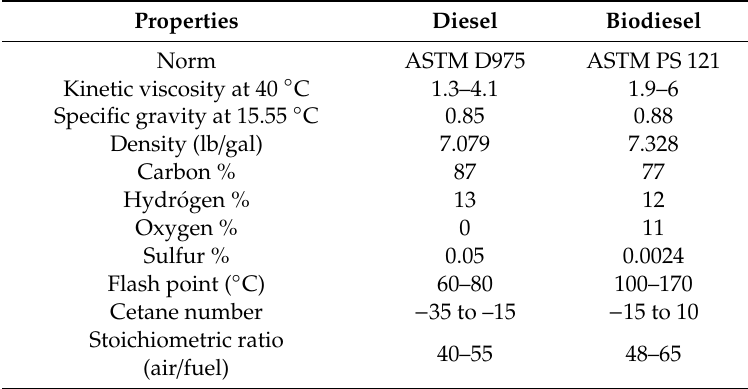
Table 3. Properties of diesel and biofuel for analytical combustion analysis